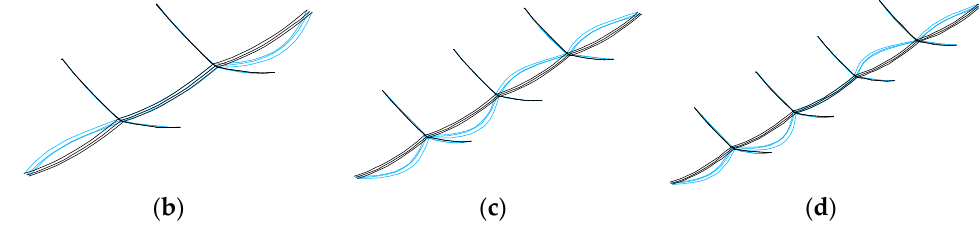
Figure 10. First asymmetric lateral bending modes of multi-span CRS. ( a ) Two spans, ( b ) 3 spans, ( c ) 4 spans, ( d ) 5 spans.